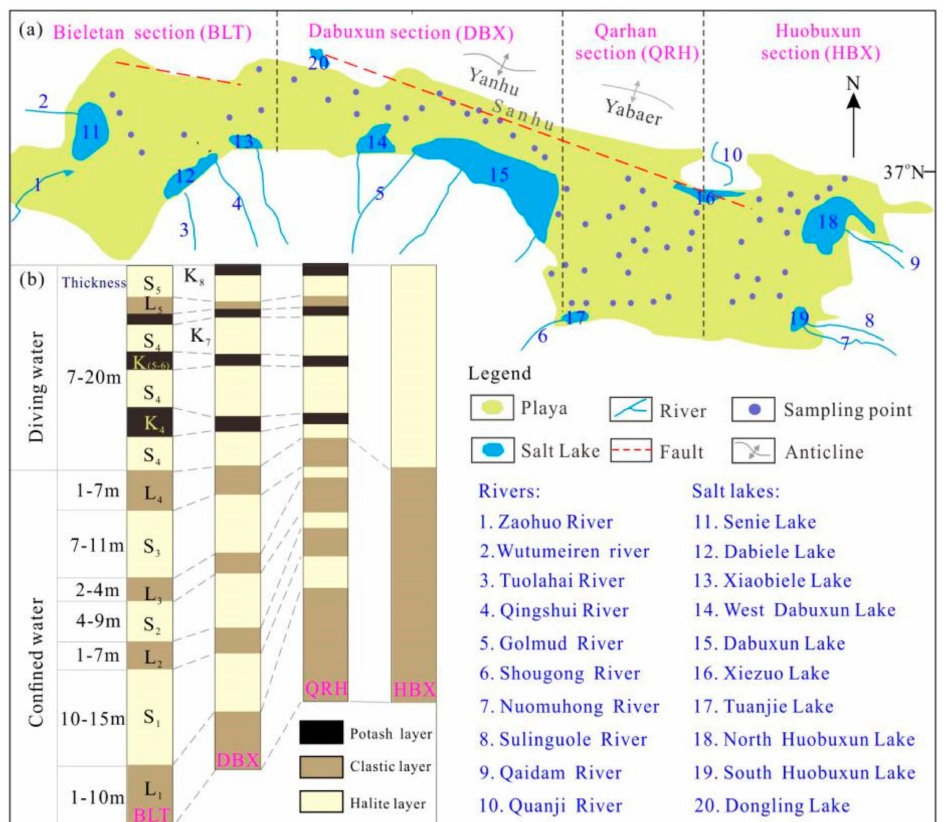
Figure 4. ( a ) The sampling sites; ( b ) spatial characteristics of salt deposits in the Qarhan Salt Lake (QSL): five halite–dominated evaporitic layers (S 1 –S 5 ) are separated by five clastic–dominated layers (L 1 –L 5 ). The layered, K-bearing minerals are mainly enriched in the S 4 (K 4 –K 7 ) and S 5 (K 8 ). Springs and rivers are the two main inflows replenishing the QSL [9,27,32,33]. The springs